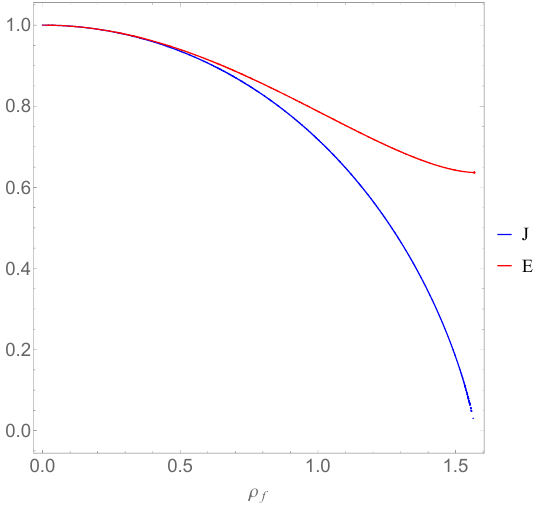
with J = 0 . 6 R 2 /α 0 . The energy E , spin S and f ), which prohibits the red region. R 2